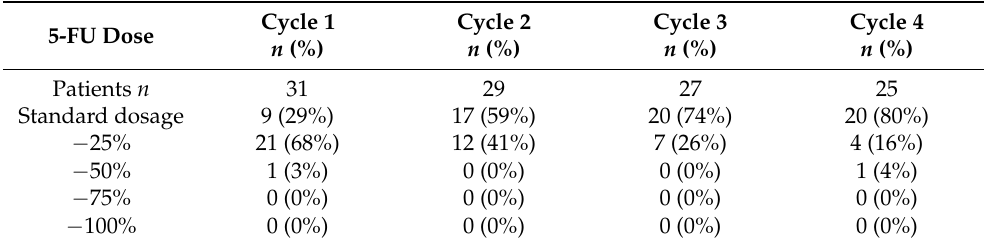
Table 5. Dosage adjustment of infusional continuous 5-FU during the first four chemotherapy treatment cycles in deficient patients ( n =